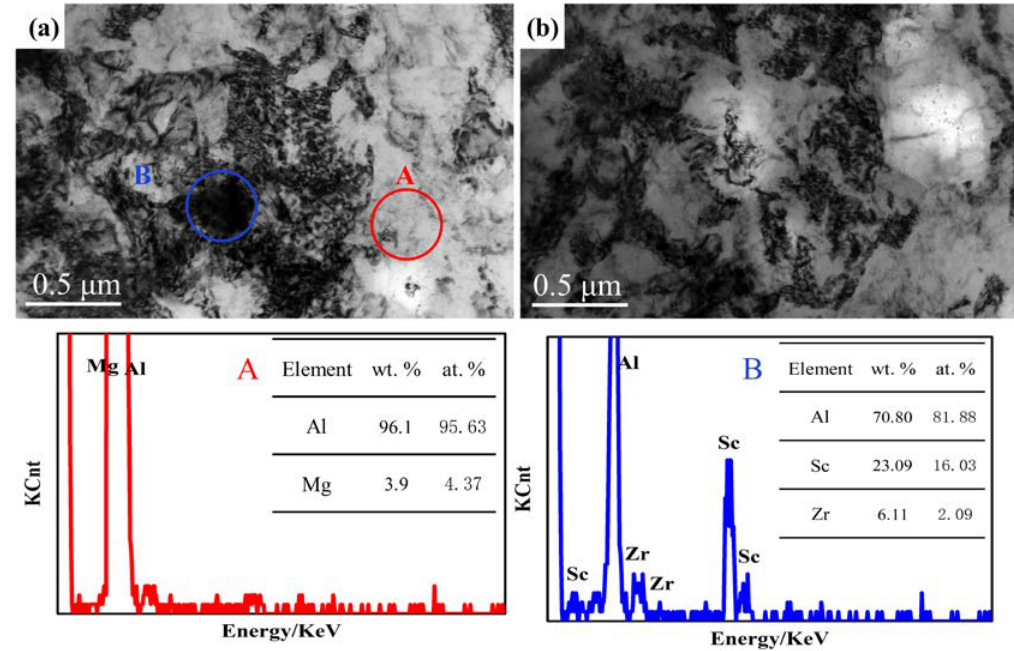
Figure 9. The TEM maps of the hot rolled Al-5Mg-2Li-0.2Sc-0.12Zr alloy, ( a ) and ( b ) are the different positions of the rolled microstructure.